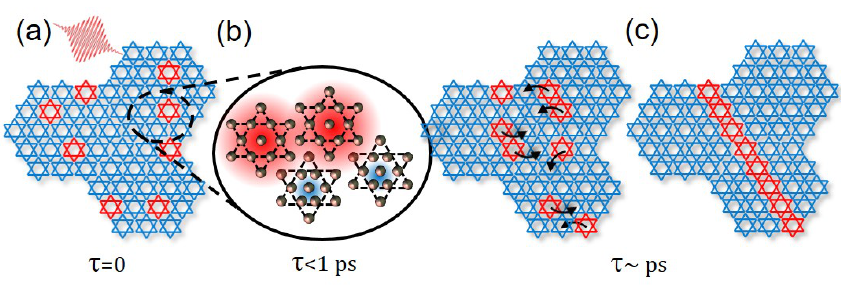
Figure 5. Proposed sequence of photo-induced dynamics. Prior to optical excitation, the structure is governed by insulating domains (blue). Optical excitation leads to randomly distributed excited (red) clusters ( a ) that act as defects for the CDW; On a timescale less than 1 ps, a majority of electronic excess energy is transferred to the lattice and the CDW amplitude mode phonon is highly populated, allowing for local hopping of the electronic excitations ( b ); After a few picoseconds, a new real-space structure is formed and the system reached its new quasi-equilibrium state ( c